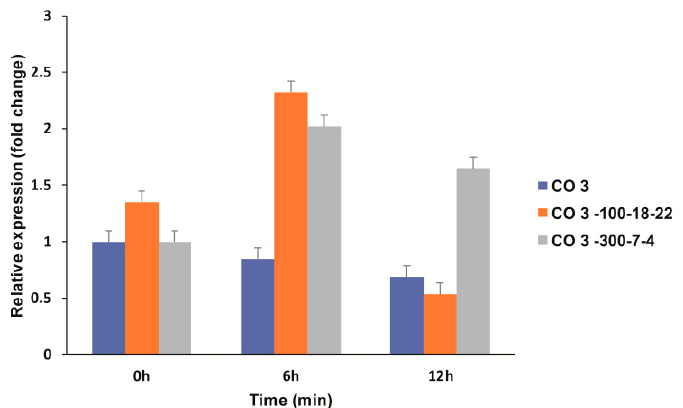
Figure 11. Relative expression profile of GA2ox 6 gene analyzed using qRT-PCR under dehydration stress for 0 h (control), 6 h (early) and 2 h (late) in 21-day-old seedlings of CO 3, CO 3-100-18-22, and CO 3-300-7-4. The relative expression ratio of each gene was calculated relative to its expression in control sample (0 h). SiAct2 was used as an internal control to normalize the data. Error bars representing standard deviation were calculated based on three technical replicates for each biological duplicate.